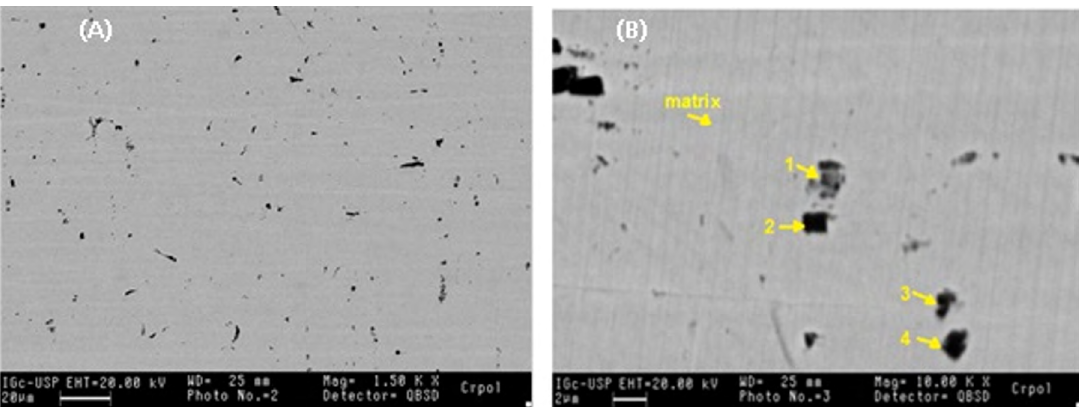
Figure 2. SEM micrographs of the AISI 409 stainless steel: a) General view; b) Detailed view showing precipitates with different morphologies.